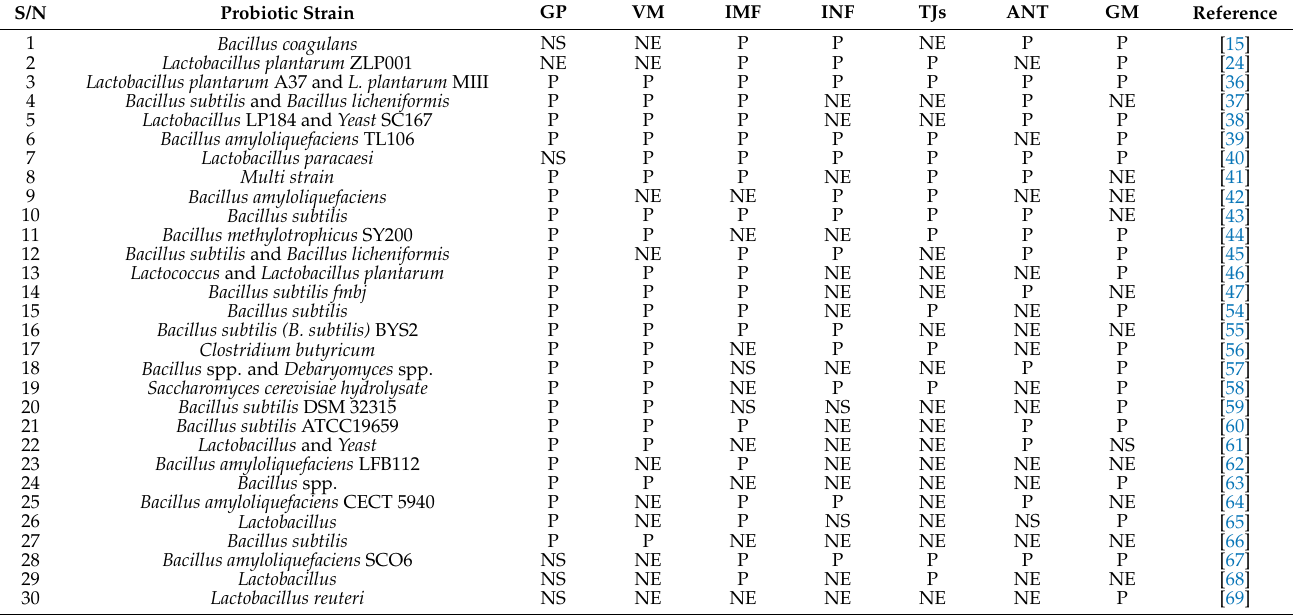
Table 1. Influence of probiotics on gut health of broilers under conventional poultry